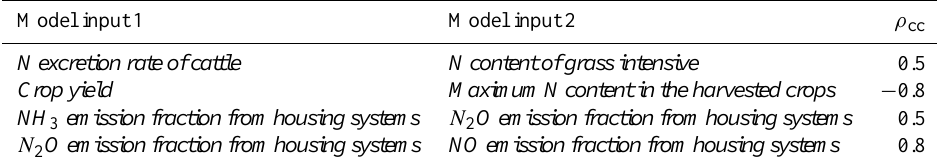
Table 2. Model inputs for which cross-correlations are included.